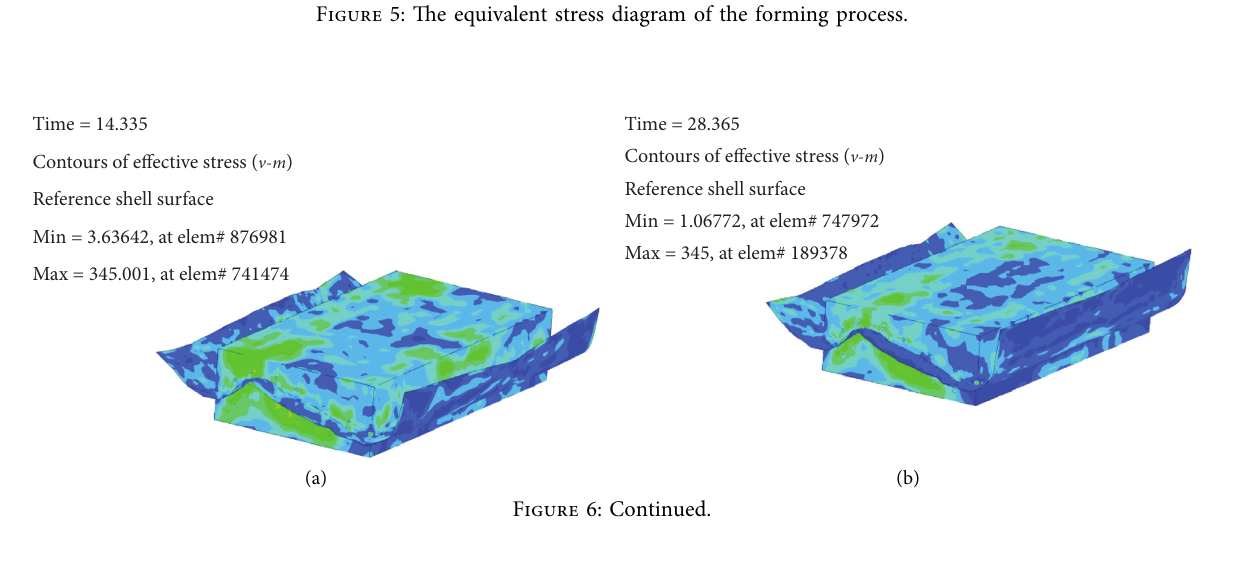
Figure 5: The equivalent stress diagram of the forming